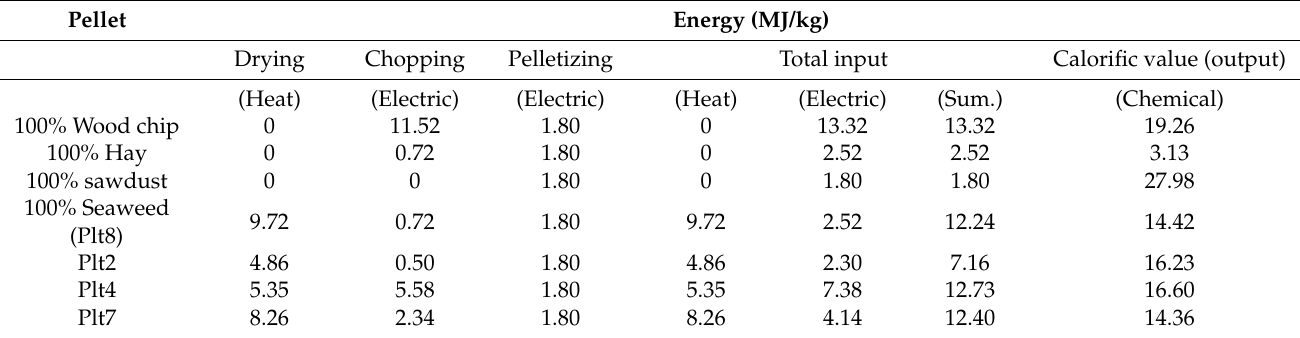
Table 4. Energy consumption for processing versus calorific values pellet